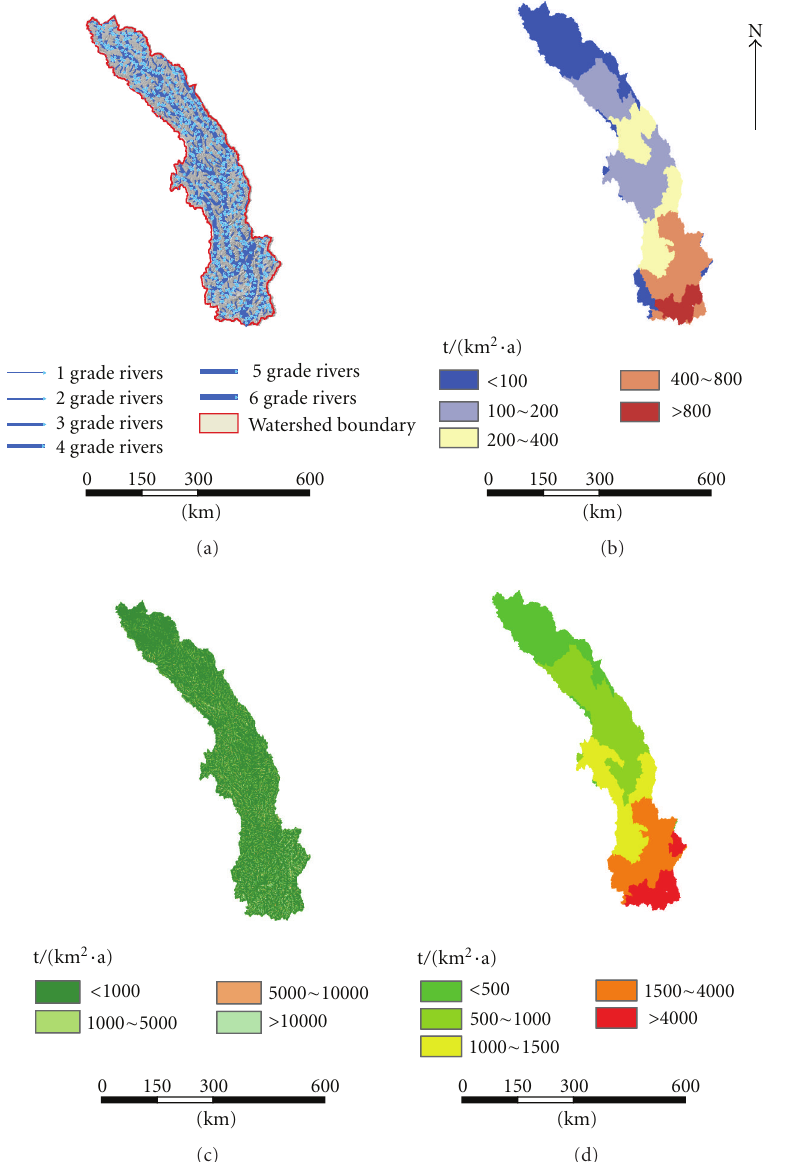
Figure 3: Spatial distributions of exporting sediment to Ertan reservoir and sediment retention of ecosystem in watershed. (a) The process of flow accumulation. (b) Average exporting sediment to Ertan reservoir of each county in 2005. (c) Sediment retention in 2005. (d) Average sediment retention of each county in